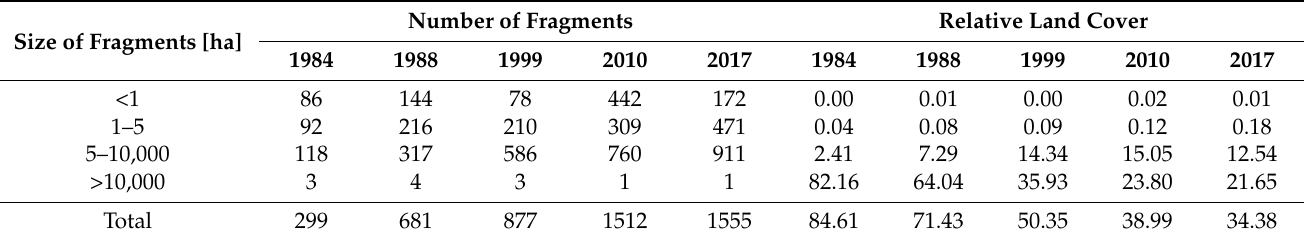
Table 2. Number of fragments and land cover rate of forest in 1984, 1988, 1999, 2010, and 2017.